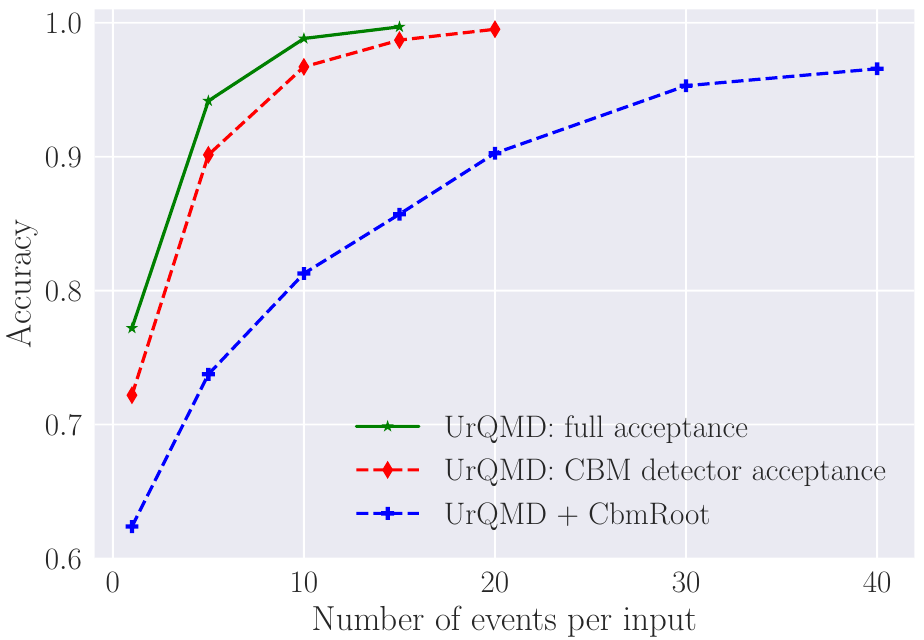
Figure 2 . (Color online) Validation accuracy of the PointNet models as a function of number of events combined to create the input. The number of training and validation samples were fixed to be 60000 and 20000 respectively for all the models although multiple events were combined to create a sample. While randomly combining events, it was ensured that an event in training sample was never present in a validation sample. The DL models achieved greater than 99% accuracy with the combination of 15 events in an ideal case while 20 events had to be combined in the presence of an acceptance cut. However, the DL model required a combination of 40 events to achieve about 96% accuracy in a more realistic experimental